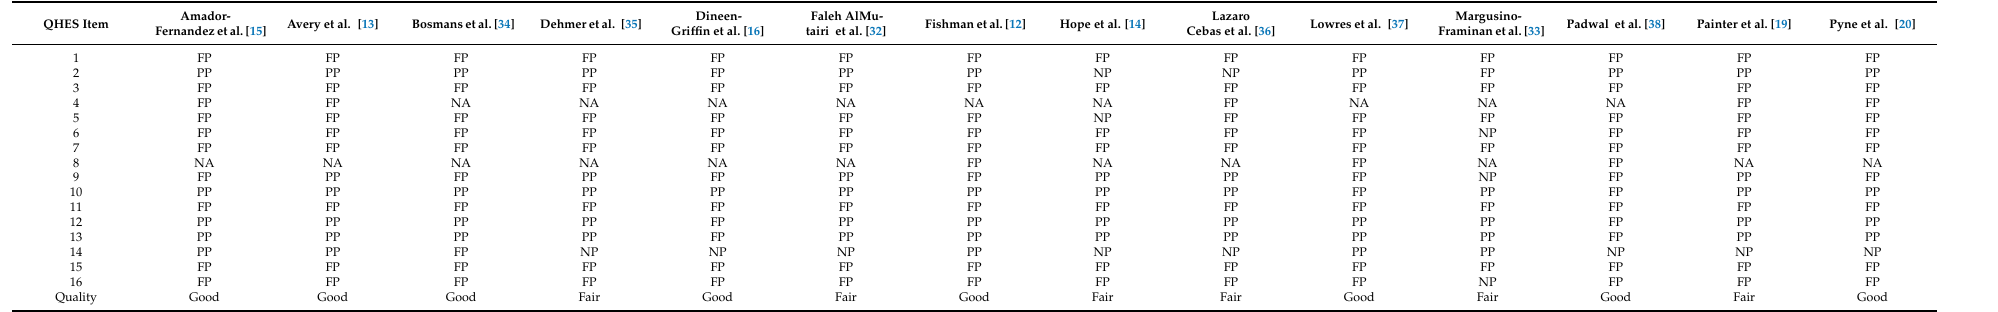
Table 4. Results of the study